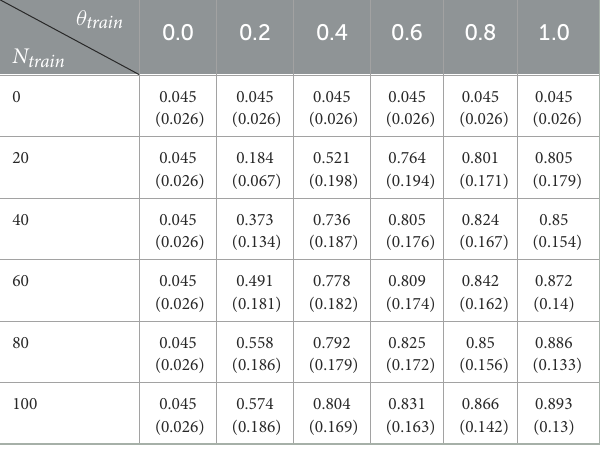
TABLE 8 Adoption rate by level of environmental sensibilisation ( θ env ) and number of farmers concerned ( N env ): mean value for the 50 replications and standard deviation in brackets.